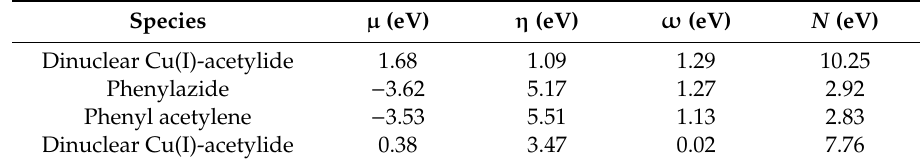
Figure 4. Structure of the simple dinuclear copper(I)-acetylide species ( A ) and dinuclear bis(pyrazolyl)borato]copper(I)-acetylide ( B ). Table 5. Chemical potential ( µ ), chemical hardness ( η ), global electrophilicity ( ω ), and global nucleophilicity ( N ) of methylazide, methyl acetylene, and dinuclear copper-acetylide